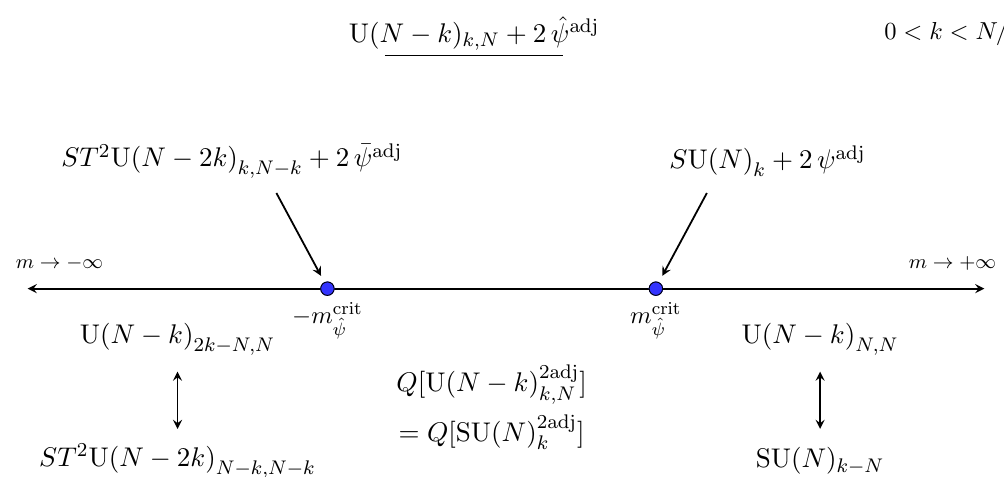
Figure 8 . Phase diagram of strongly coupled left dual description of (cid:12)gure 7, which is U( N (cid:0) k ) k;N with two real adjoint fermions for 0 < k < N= 2. It describes the (cid:12)rst step of duality chain, where the right dual description at m ^ = m +crit coincides with original theory thus shares the same ^ quantum phase with original theory as Q [SU( N ) 2adj ] = Q [U( N (cid:0) k ) k;N ]. Left dual description k